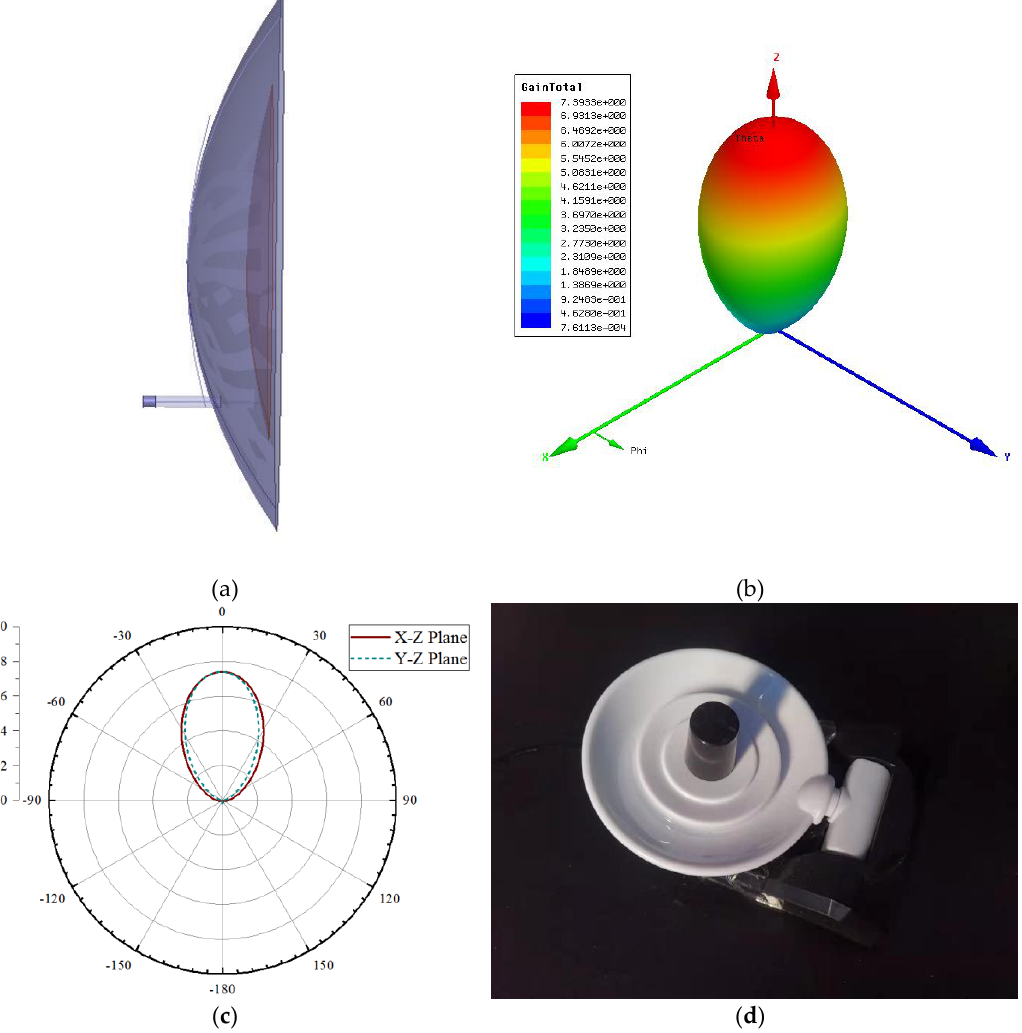
Figure 6. The directional antenna information: ( a ) the antenna model; ( b ) the antenna radiation in 3D; ( c ) the antenna radiation; ( d ) the antenna prototype.